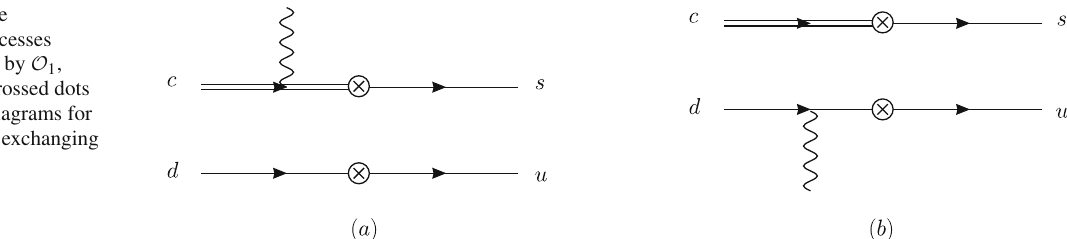
Fig. 1 W-exchange bremsstrahlung processes cd → us γ induced by O 1 , where the double crossed dots denote O 1 , 2 . The diagrams for O 2 are similar, just exchanging u and